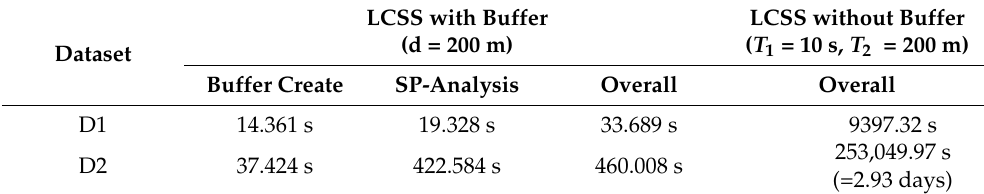
Table 2. Time consumption of LCSS similarity